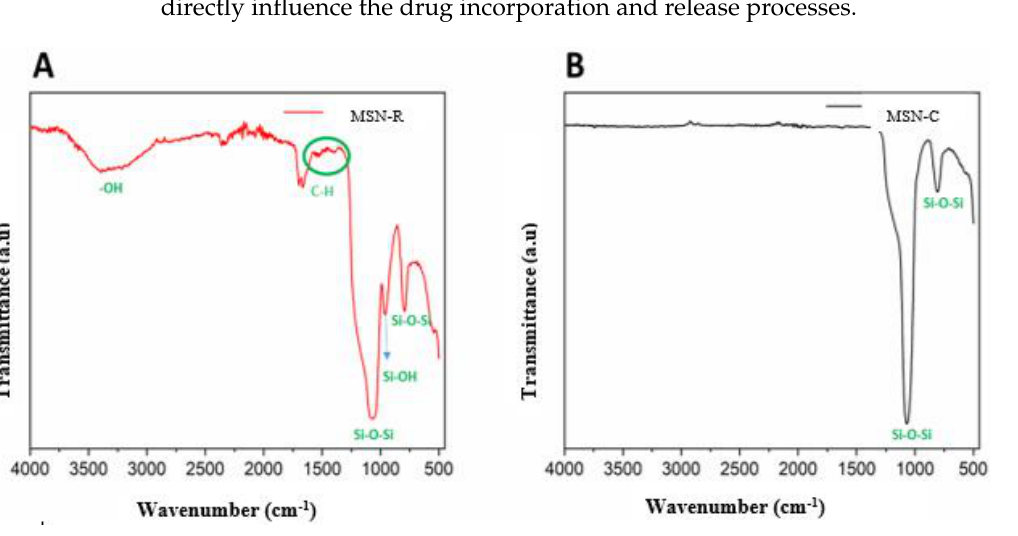
Figure 1. MSN-R and MSN-C infrared spectra. Legend: ( A ): MSN-R: refluxed mesoporous silica